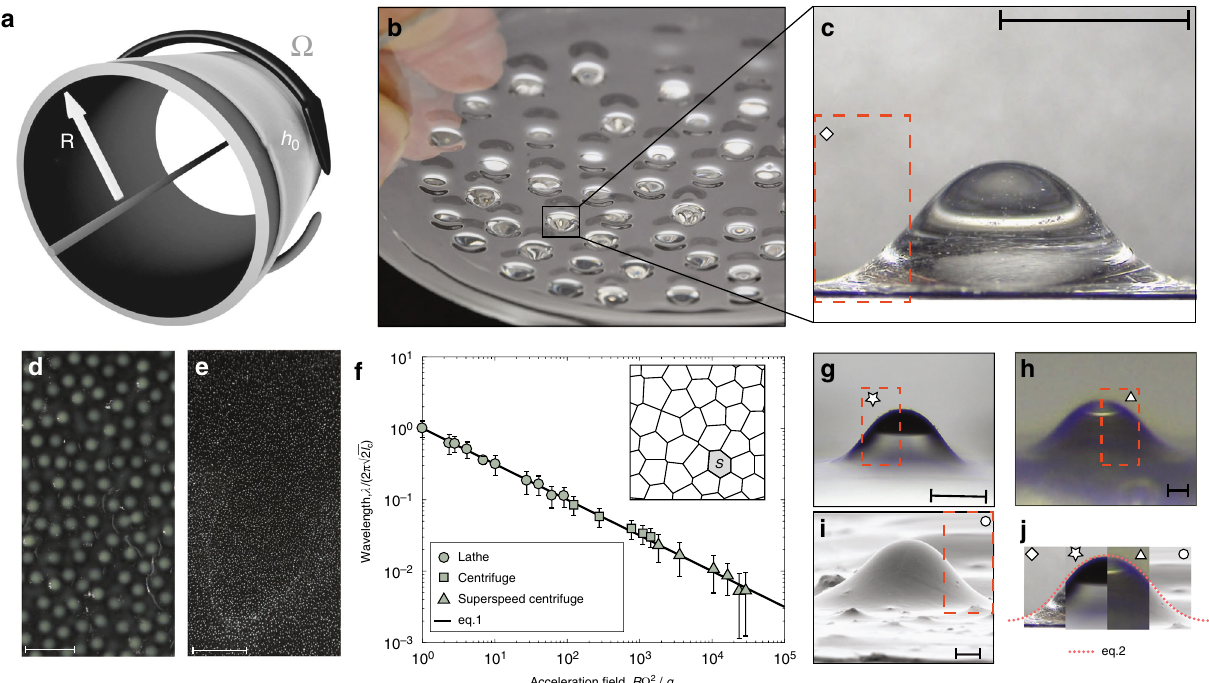
Fig. 1 Harnessing the Rayleigh – Taylor instability at the materials scale. a A thin polymeric fi lm is initially deposited onto a cylinder substrate which is then rotated so that its interface destabilizes to the Rayleigh – Taylor instability under the action of the destabilizing acceleration a = R Ω 2 . b Liquid polymer drops grow into a pattern that freezes as the polymer cures. c The resulting elastic drops may be easily peeled from the substrate. Scale bar, 5 mm. d , e Drop patterns formed with a = 10.2 g and a = 1421 g , respectively. Scale bars, 1 cm. f The lattice wavelength, λ , is a function of the acceleration fi eld generating drops with size ranging from 10 mm to 50 μ m. The error bars correspond to the standard deviation of measurements obtained across the sample. Inset: a typical Voronoi construction generated using the drops positions. g – i Experimental pictures and SEM images of drops obtained with an acceleration fi eld R Ω 2 / g = 42 ( g , scale bar 500 μ m), 640 ( h , scale bar 50 μ m), 12,266 ( i , scale bar 10 μ m). j Photomontage combining portions of drops ( c ) and g – i compared to theory (dashed red